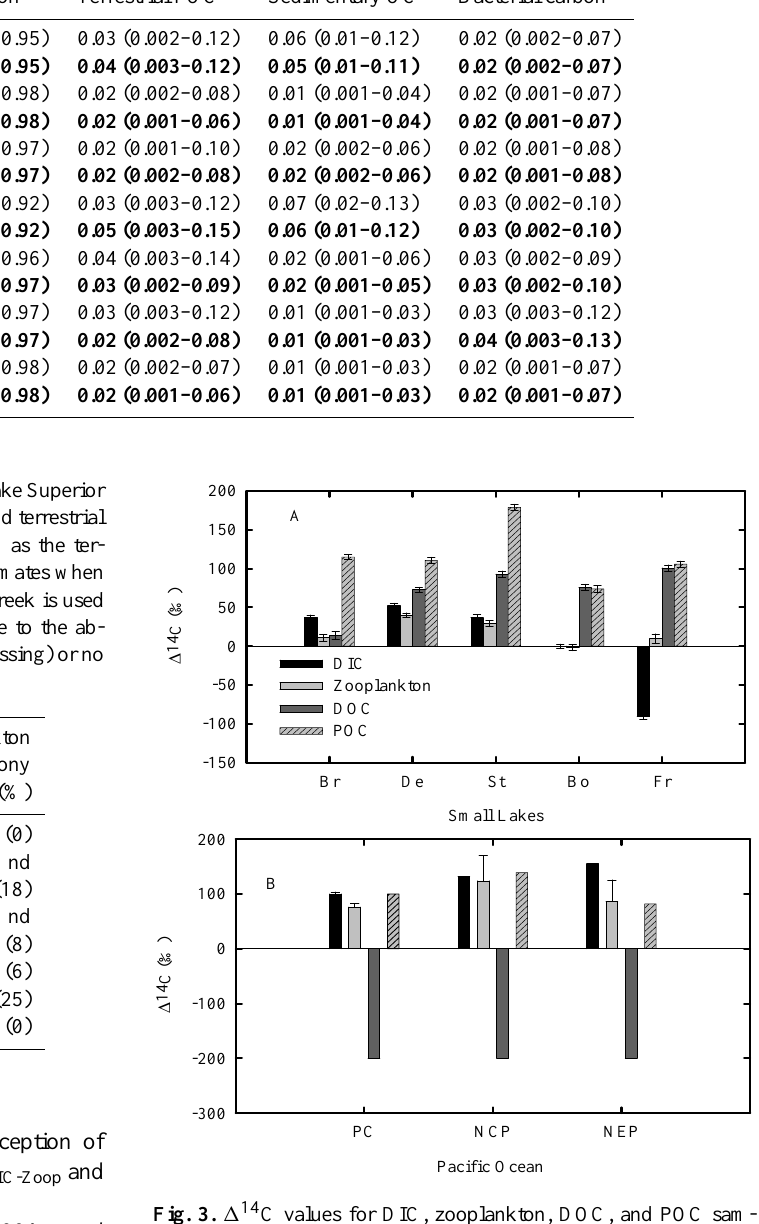
Figure 3. Fig. 3. 1 14 C values for DIC, zooplankton, DOC, and POC sam- ples in (A) selected small lakes that include Bran-de-Scie (Br), Des Monts (De), Stukely (St), Bowker (Bo), and Fraser (Fr) Lakes, and (B) sites in the Pacific Ocean that include Pacific coastal ocean (PC), North Central Pacific (NCP), and North Eastern Pacific (NEP). Data adapted from Williams et al., (1987), Druffel and Williams, (1990, 1991), Druffel et al.,